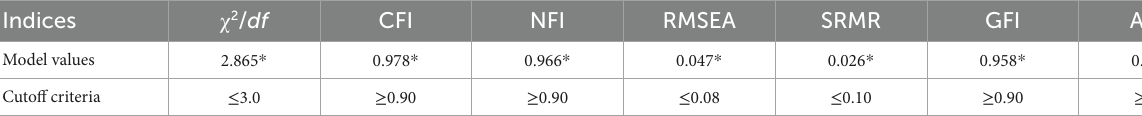
TABLE 8 Model fit indices of model 4.